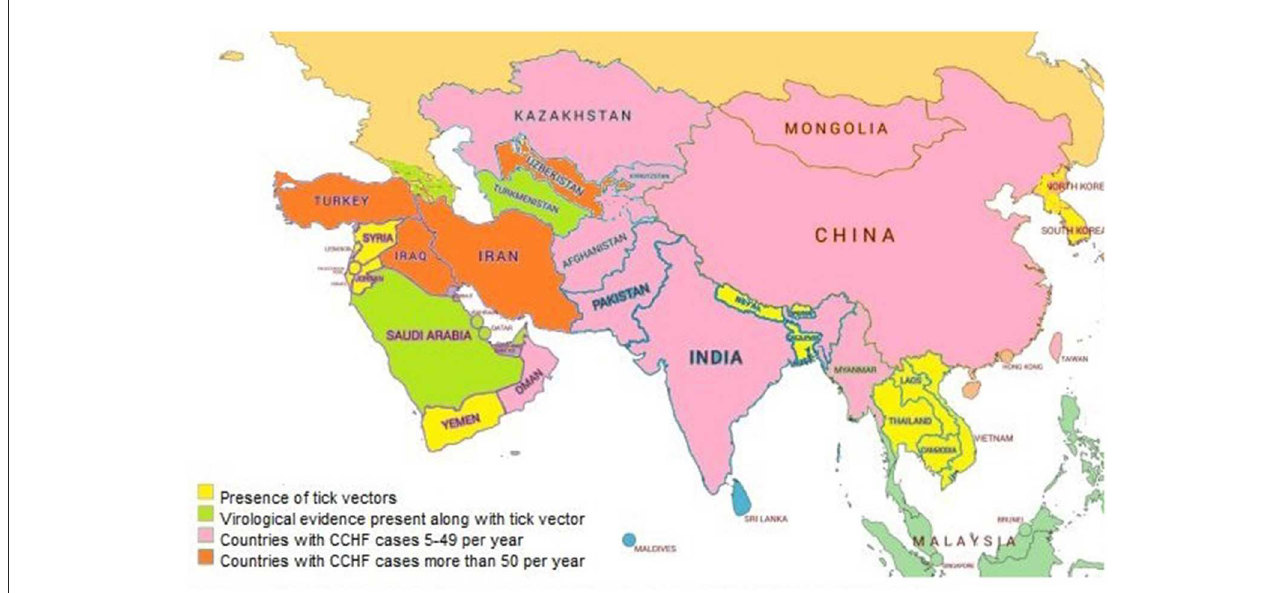
FIGURE2 Distribution pattern of CCHF in Asian and Middle East